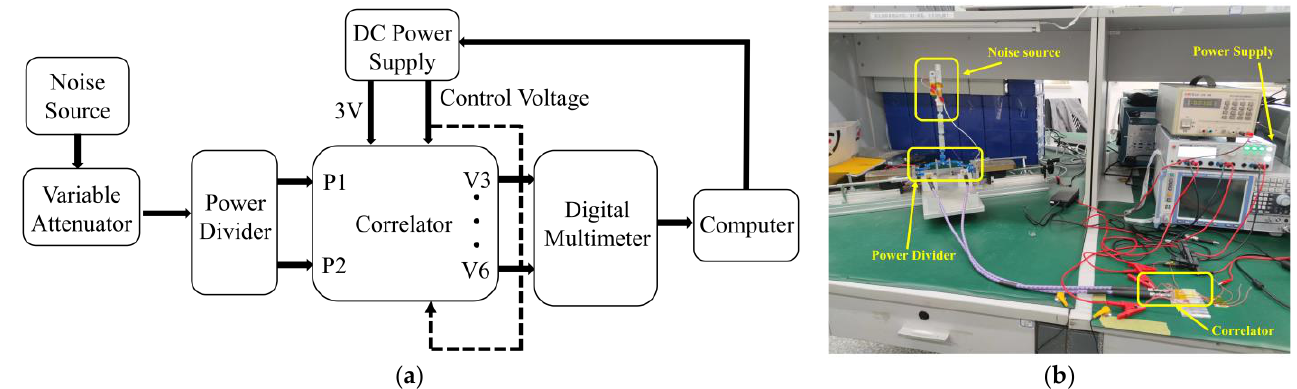
Figure 15. The proposed broadband noise measurement system : ( a ) block diagram; ( b ) test site.